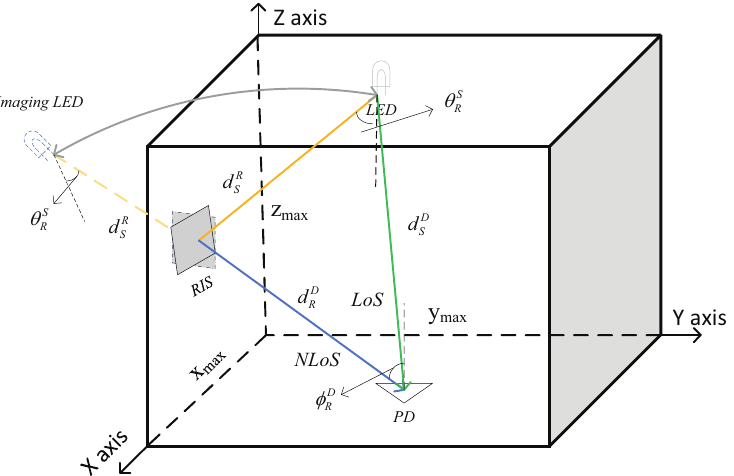
Figure 1. Scenario 1: An indoor VLC system contains an AP, a fixed user, and an RIS.